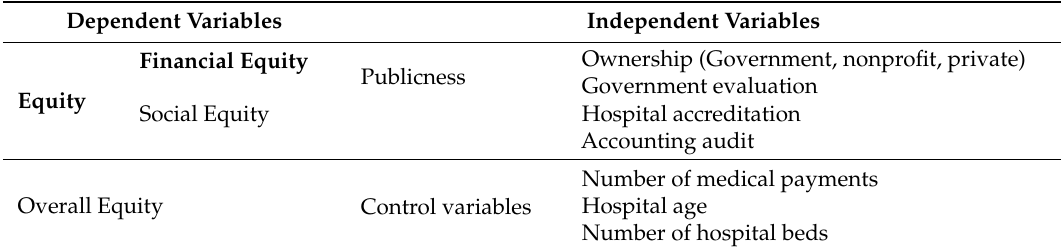
Table 1. Analytical framework for hospital performance